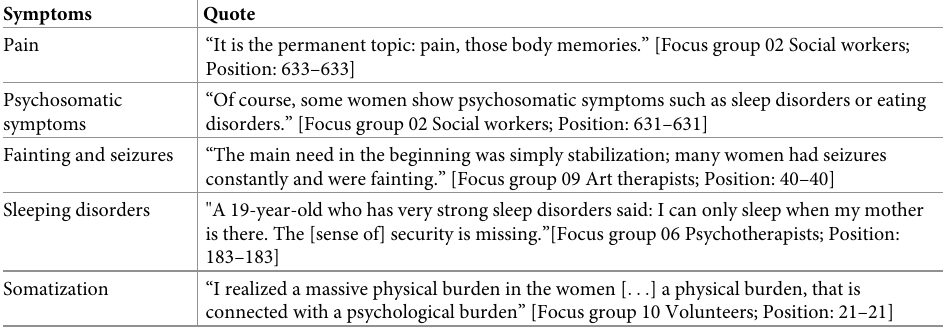
Table 2. Somatic symptoms of the traumatized Yazidi women from the care providers’ perspective.